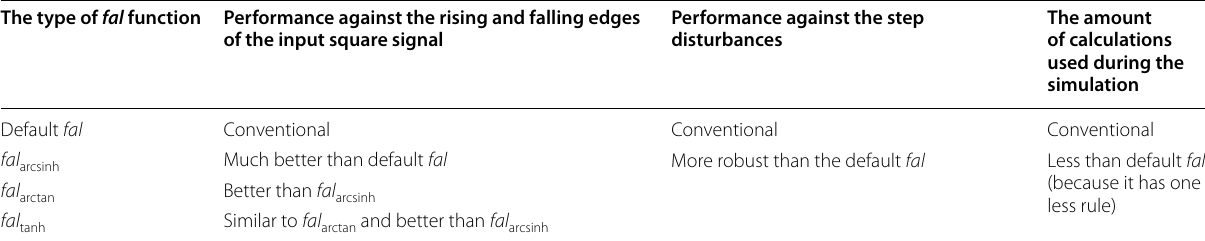
Table 4 Comparison of the different fal functions used in the conventional ADRC The type of fal function Performance against the rising and falling edges of the input square signal